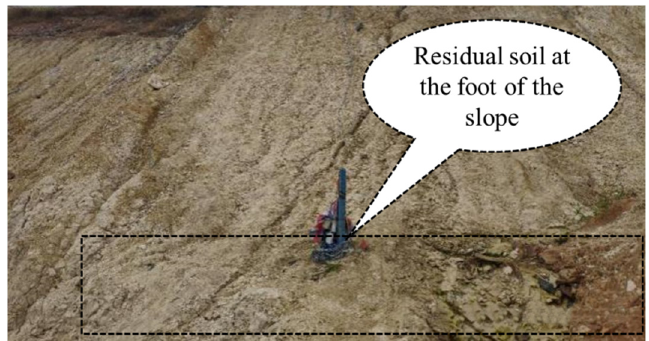
Figure 14. Natural side slope observation map.